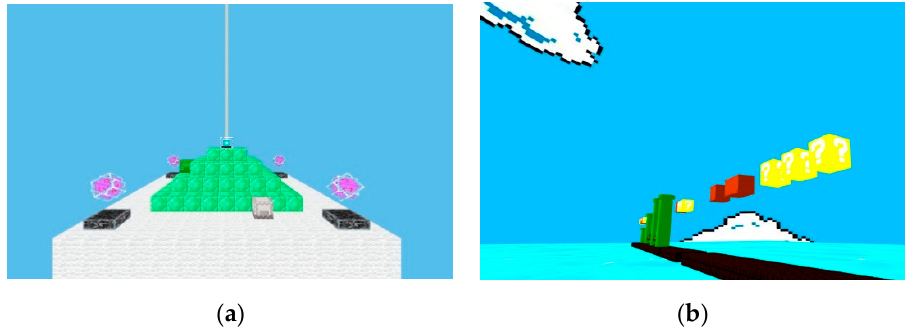
Figure 2. ( a ) Beacon is a project by Pedro Ermida and Rúben Ferreira; ( b ) A WebVR interpretation of the Super Mario environment by Luis